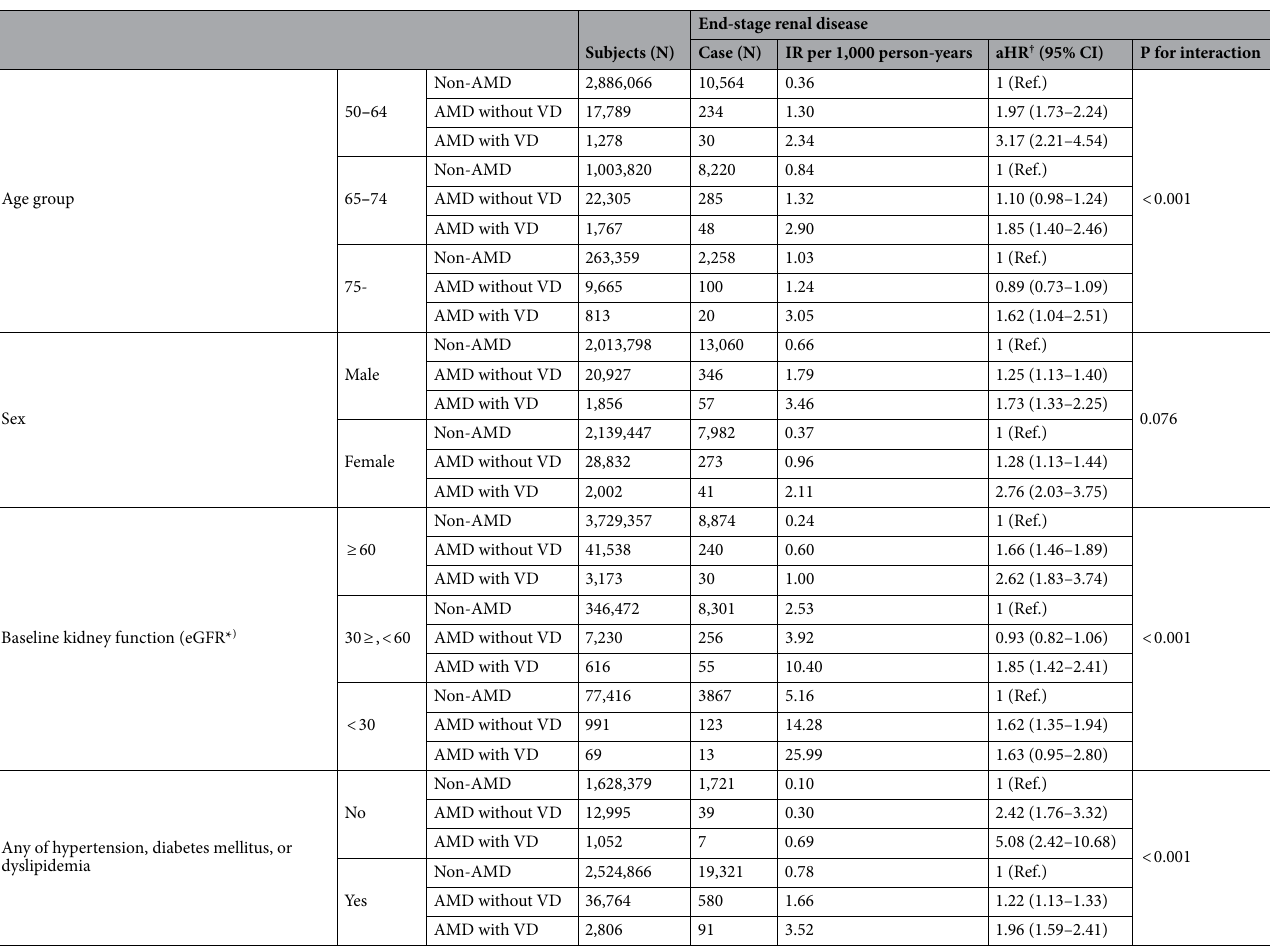
Table 3. Risk of ESRD by AMD and visual disability according to age, sex, baseline kidney function, and cardiometabolic comorbidities. eGFR estimated glomerular filtration rate; VD visual disability. *Units: mL/ min/1.73 m 2 . † adjusted for age and sex, income, area of residence, body mass index, smoking, alcohol consumption, and regular physical activity, fasting serum glucose level, serum hemoglobin level, estimated glomerular filtration rate, hypertension, diabetes mellitus, dyslipidemia, and Charlson comorbidity